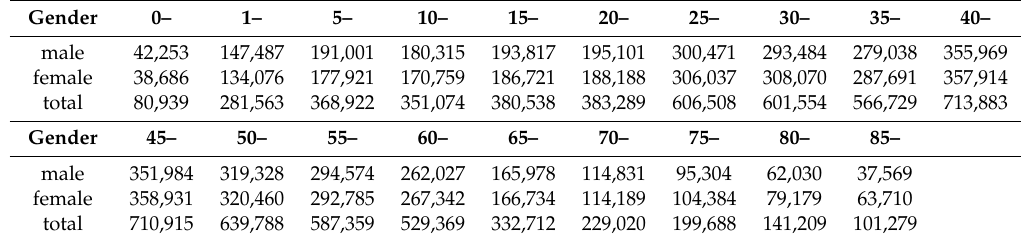
Table 1. The population of Qingdao by sex and